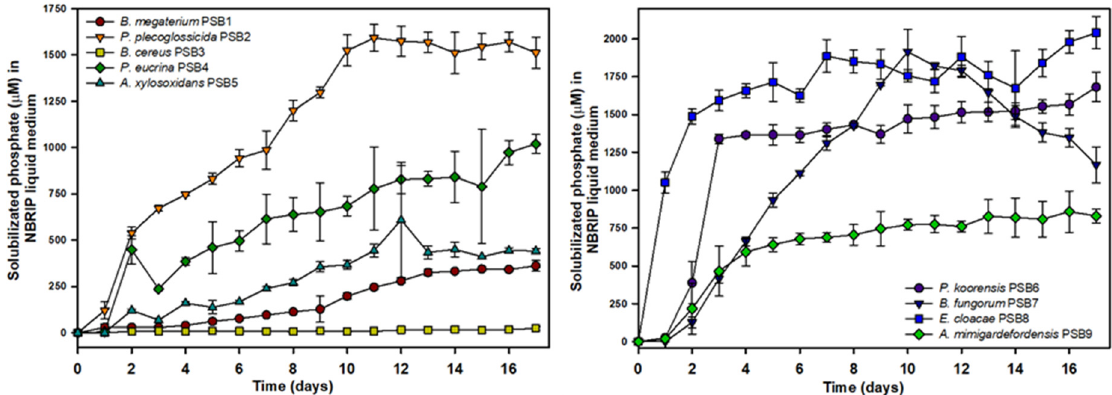
Figure 1. Evolution of phosphate solubilization in NBRIP liquid medium by bacterial isolates PSB1 to PSB9. Data shown (with SD) are the average of three independent experiments. Table 2. Extracellular phosphatase and phytase activities detected in the PSB isolates.